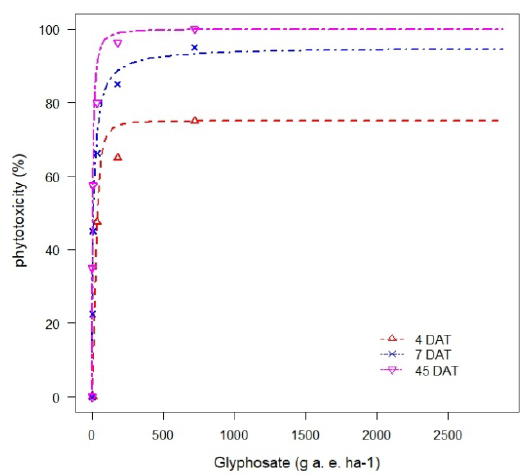
Figure 4. Phytotoxicity on A. retroflexus as influenced by glyphosate dose 4, 7, and 45 days after treatment (DAT).